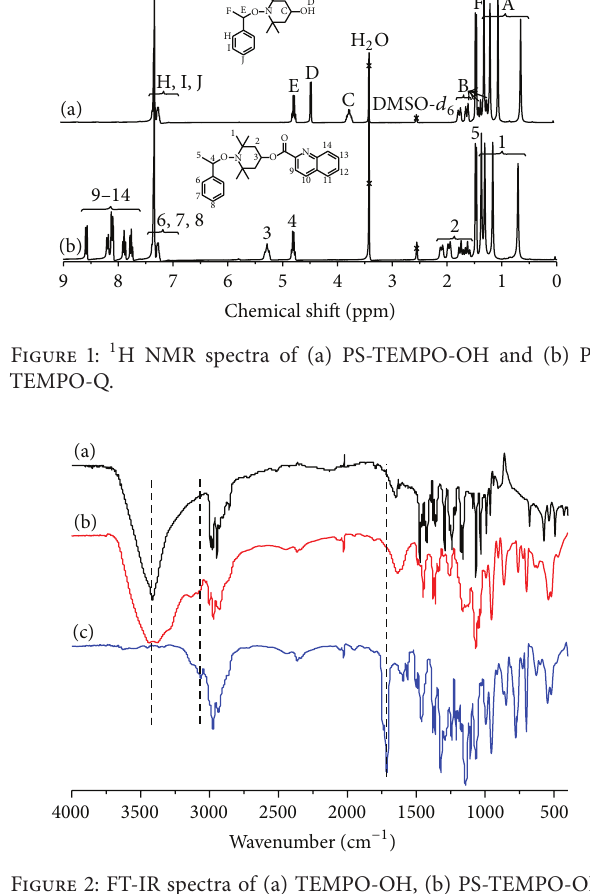
Figure 2: FT-IR spectra of (a) TEMPO-OH, (b) PS-TEMPO-OH, and (c)